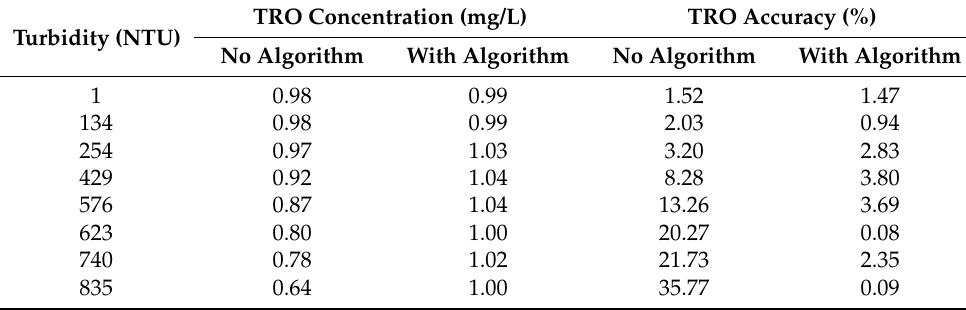
Table A1. TRO concentration and accuracy by turbidity with or without the proposed algorithm at 1 mg/L TRO concentration.